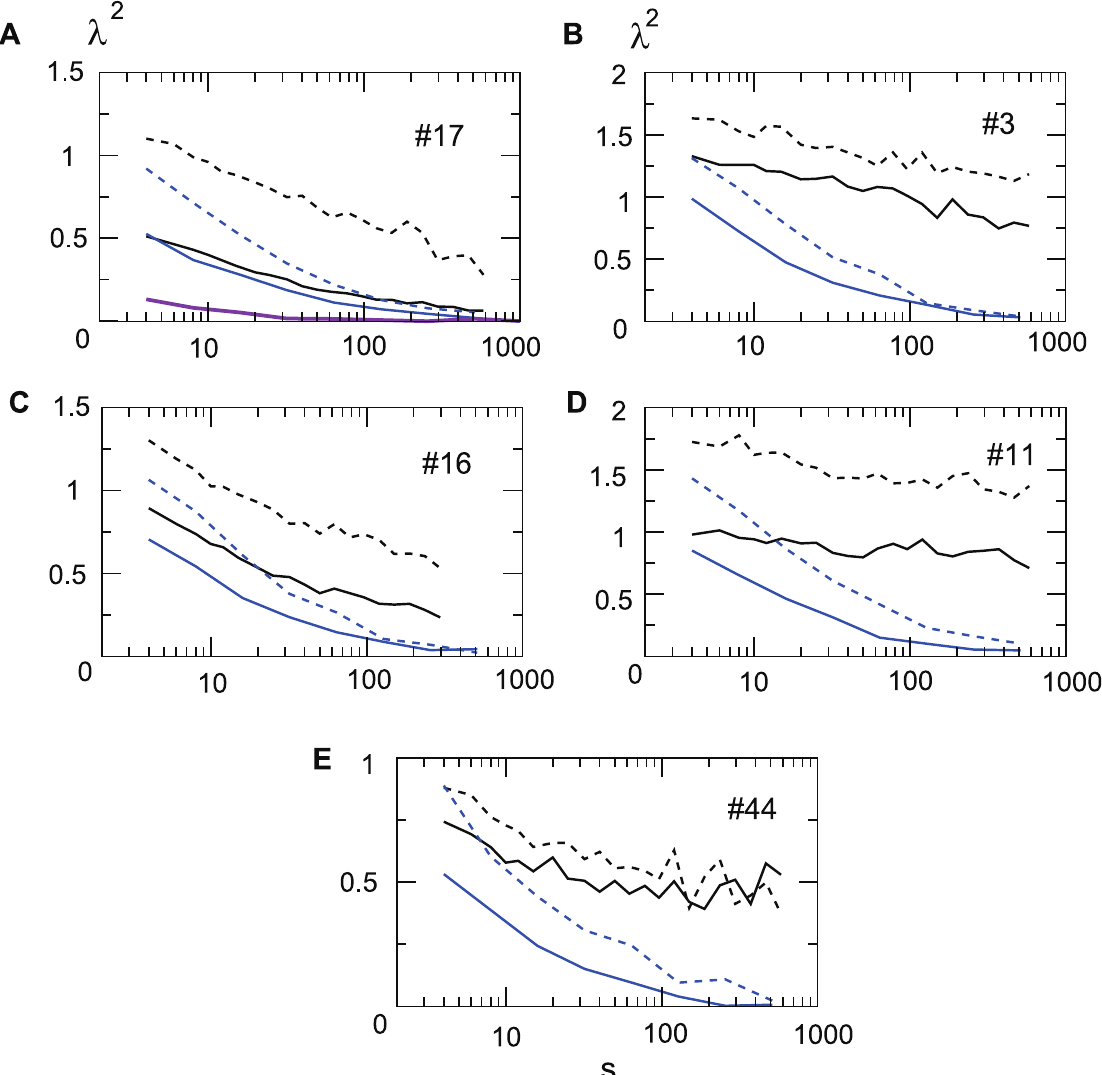
Figure 3. Scale dependence of the non-Gaussianity evaluated. The l 2 values that quantify the non-Gaussianity are plotted against a non- dimensional scale (number of ISI’s) ranging from s=4 to s=582. The solid and dashed black lines represent l 2 values calculated from spike trains during sleeping and waking, respectively. The blue lines represent l 2 values calculated from spike trains of which the ISI’s have been randomly shuffled. Five neurons, # 17 (A), # 3 (B), # 16 (C), # 11 (D) and # 44 (E), were taken as examples. The non-Gaussianity calculated from a Poissonian spike train is shown as a reference in purple in (A). The non-dimensional maximum scale s=1000 corresponds with the time scale through individual mean firing rates of neurons. The corresponding time scales are 120s (sleeping) and 130s (waking) for # 17, 420s (sleeping) and 630s (waking) for # 3, 450s (sleeping) and 590s (waking) for # 16, 630s (sleeping) and 430s (waking) for # 11, 500s (sleeping) and 590s (waking) for # 44.